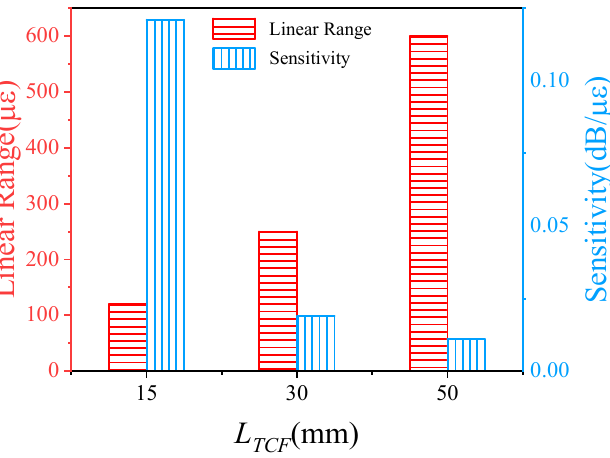
Figure 6. Comparison of sensitivities and linearity ranges with different L TCF .